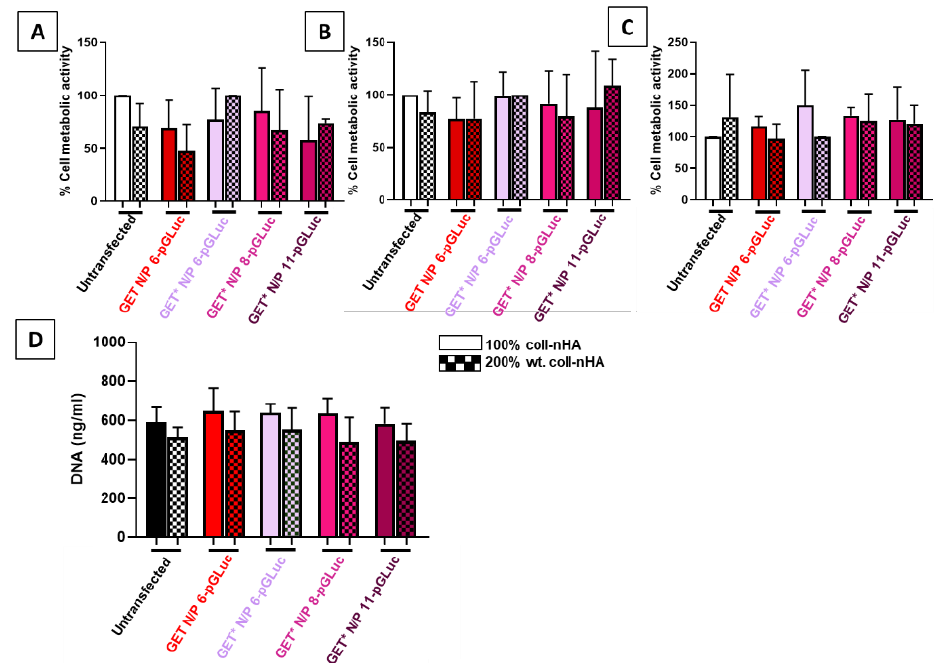
Figure 4. GET* nanoparticles on either 100% wt. or 200% wt. coll–nHA scaffolds had no adverse effect on cell metabolic activity at ( A ) day 3, ( B ) day 7, or ( C ) day 10. ( D ) Cell proliferation (DNA ng/mL) was not affected by transfection with gene-activated scaffolds. Error bars represent ± SD, n = 3 tested in triplicate.